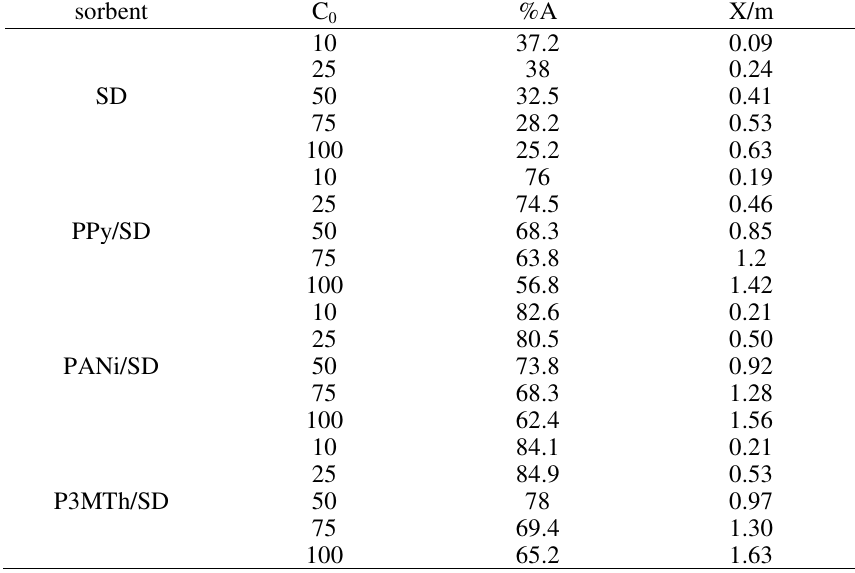
Table 1. Effect of the initial As(III) concentration on sorption by SD, PPy/SD , PANi/SD and P3MTh/SD (using batch